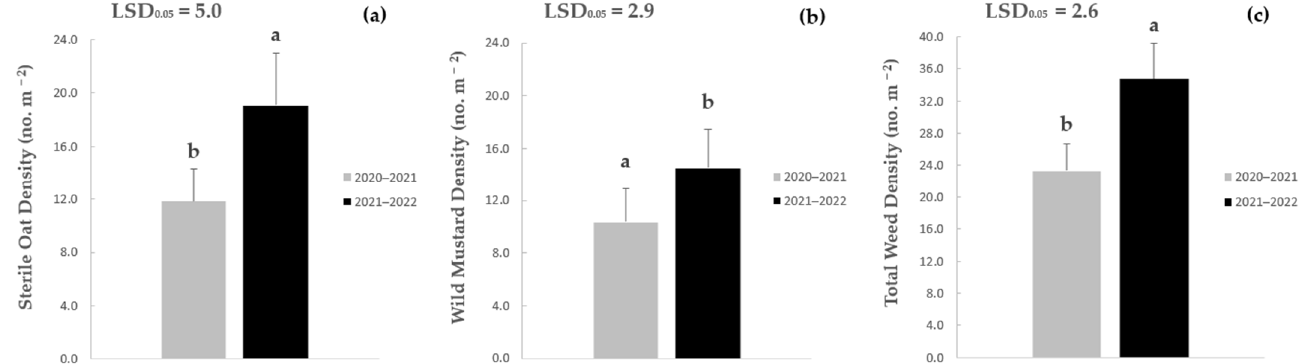
Figure 1. Weed density (no. m −2 ) in 2020–2021 and 2021–2022. Data refer to ( a ) sterile oat, ( b ) wild mustard ( b ), and ( c ) total weed density (“no.” is the abbreviation of “number”). Numbers followed by different letters are significantly different. Vertical bars indicate standard errors.